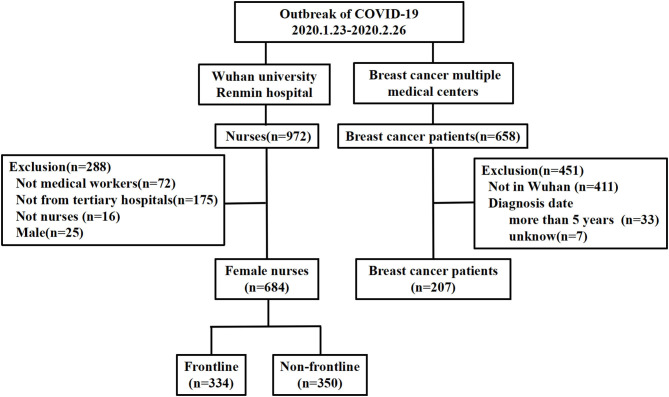
Flowchart of the recruitment of the patients and nurses.